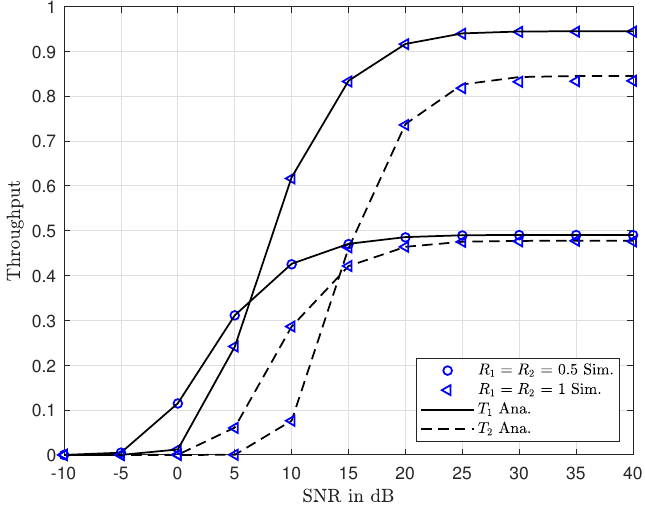
Figure 7. Throughput of U 2 vs. the target rate R 1 = R 2